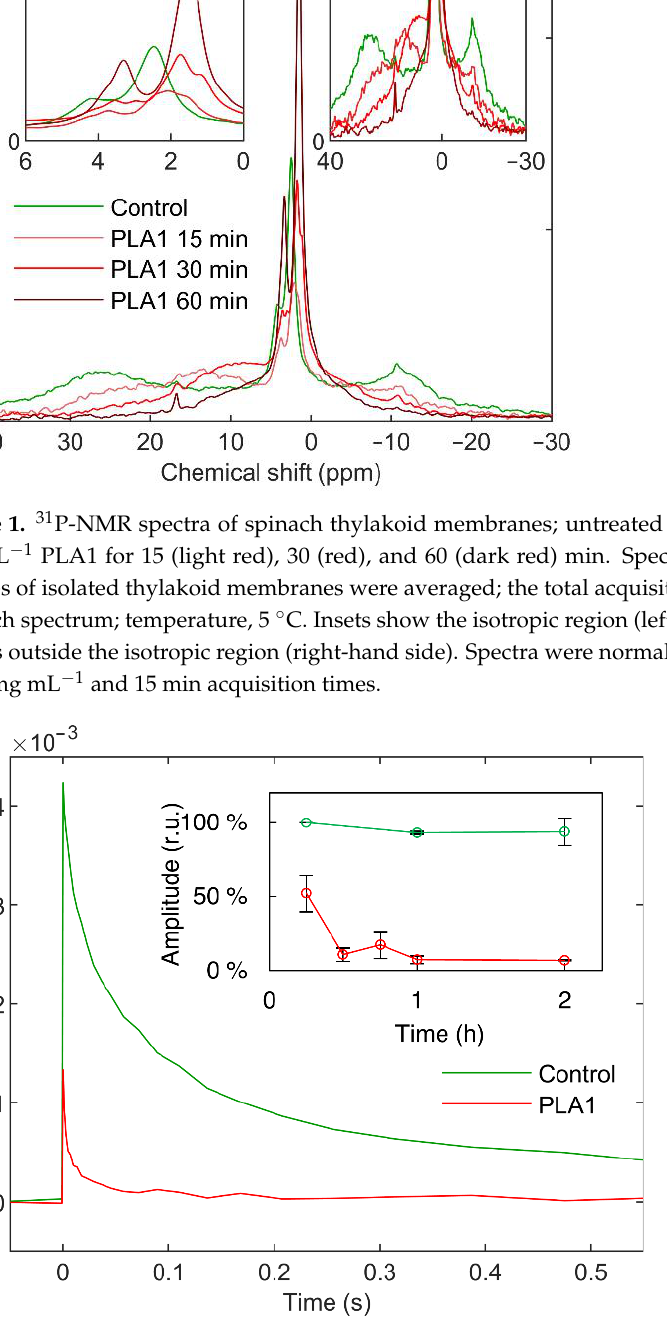
Figure 2. ΔA 515 electrochromic absorbance shift transients of isolated spinach thylakoid membranes; untreated (green) and treated with 2 U mL − 1 PLA1 (red) for 15 min. Inset shows the relative initial amplitudes as a function of time; mean values and standard deviations are from three independent experiments.